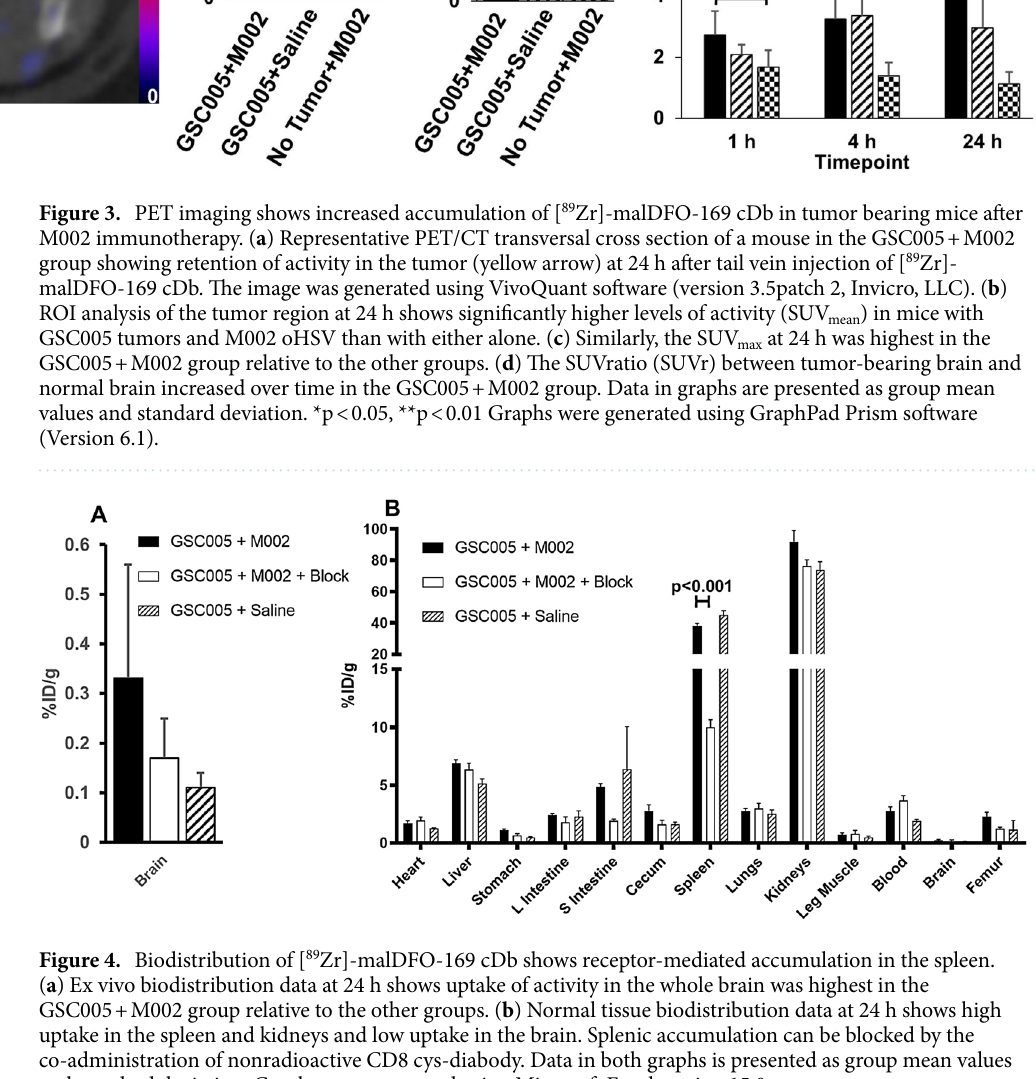
Ex vivo analyses of brain tissues showed co‑localization of [ 89 Zr]‑malDFO‑169 cDb and CD8 + cells in orthotopic glioma tumors treated with oHSV. firmed to be tumor by H&E staining relative to levels of activity in contralateral normal brain (Supplementary Fig. 3). Immunohistochemistry showed more intense CD8 + staining in and around tumors from mice treated with oHSV (Fig. 5A,B) compared to mice treated with saline (Fig. 5C–E). These results support the link between oHSV immunotherapy, CD8 + cell recruitment, and specific retention of [ 89 Zr]-malDFO-169 cDb in the ortho- topic murine glioma tumors observed in these studies.